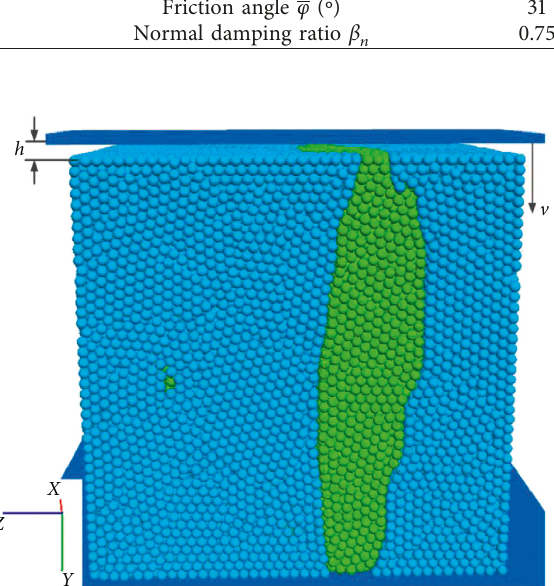
Figure 15: 3D DE model of HCR generation and in the positive y - load